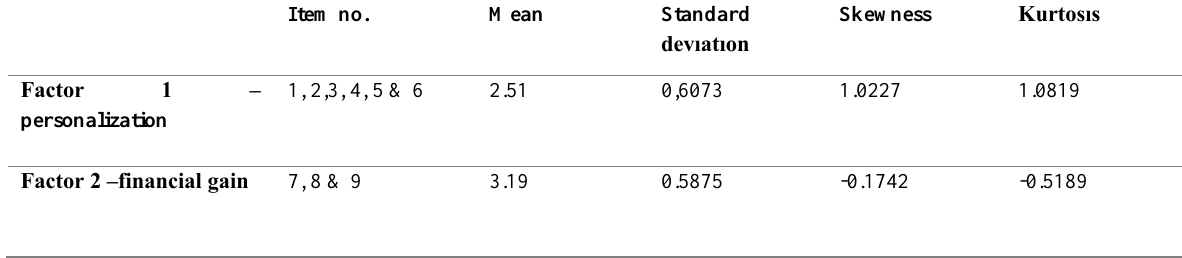
Table 3: Descriptive statistics of factors identified